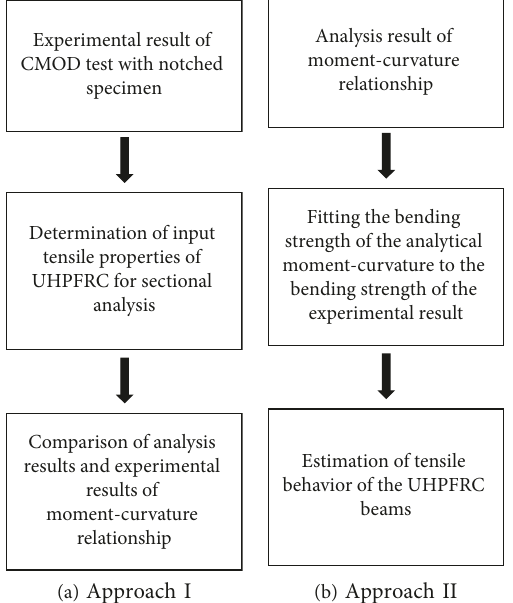
Figure 11: Approaches for estimating the tensile behavior of a UHPFRC beam.